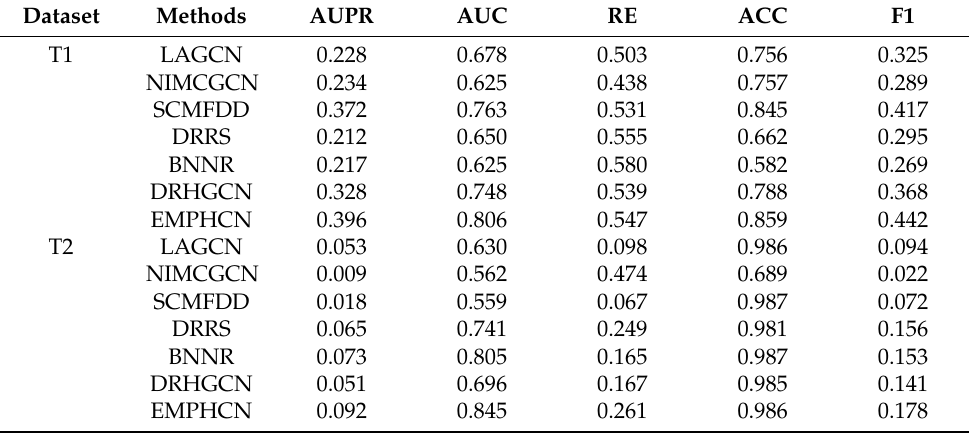
Table 3. The results of novel predictions on datasets T1 and T2 by different methods. Dataset